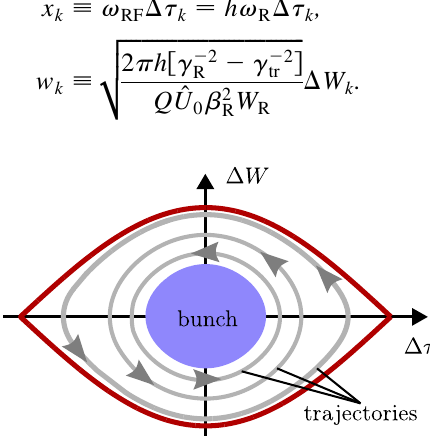
FIG. 1. Longitudinal phase plane with single-particle trajec- tories and a matched